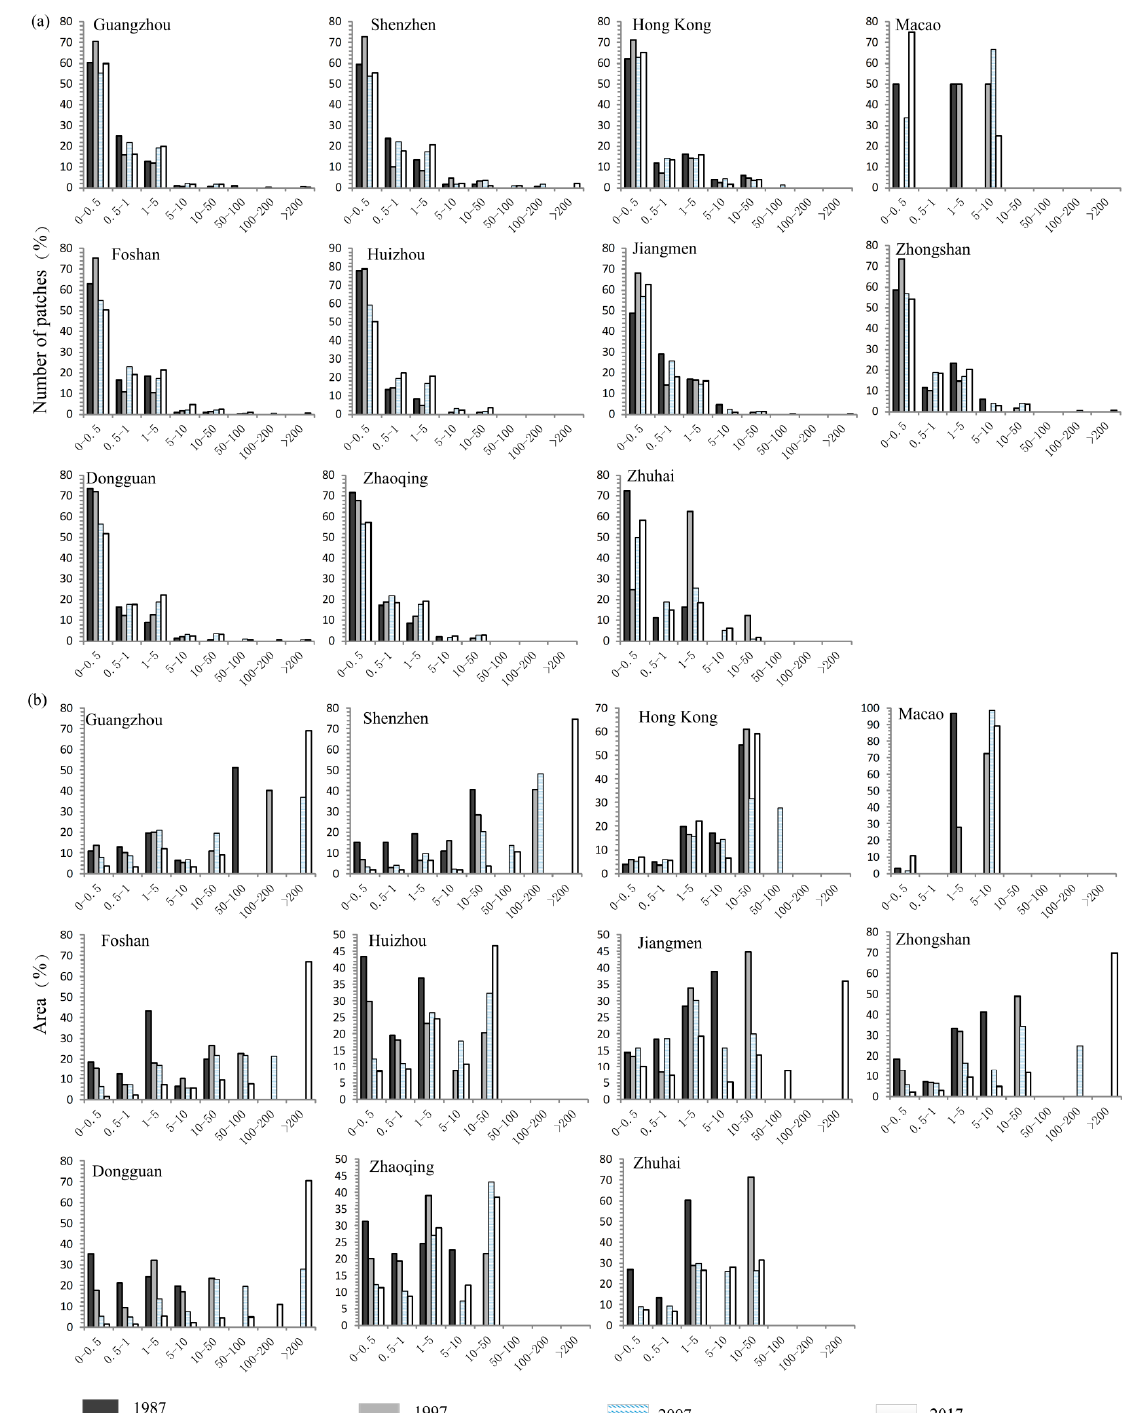
Figure 8. The frequency distribution of the number of patches ( a ) and total area ( b ) of urban land in accordance with eight patch size classes (unit: km 2 ) for 11 cities in the GBA between 1987 and 2017.